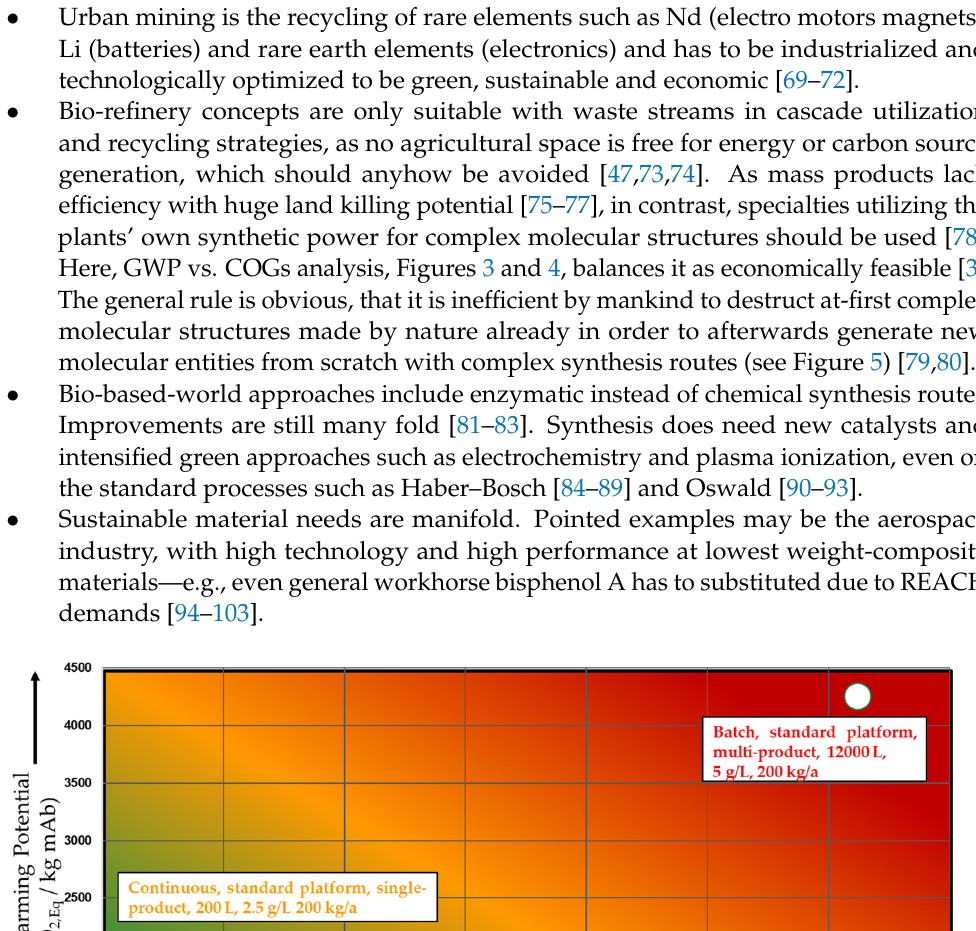
Figure 4. Botanicals GWP (global warming potential) vss COG portfolio. •